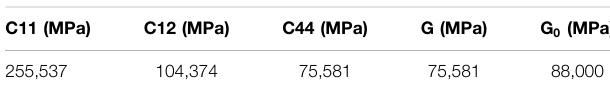
TABLE 3 | Constitutive modulus.